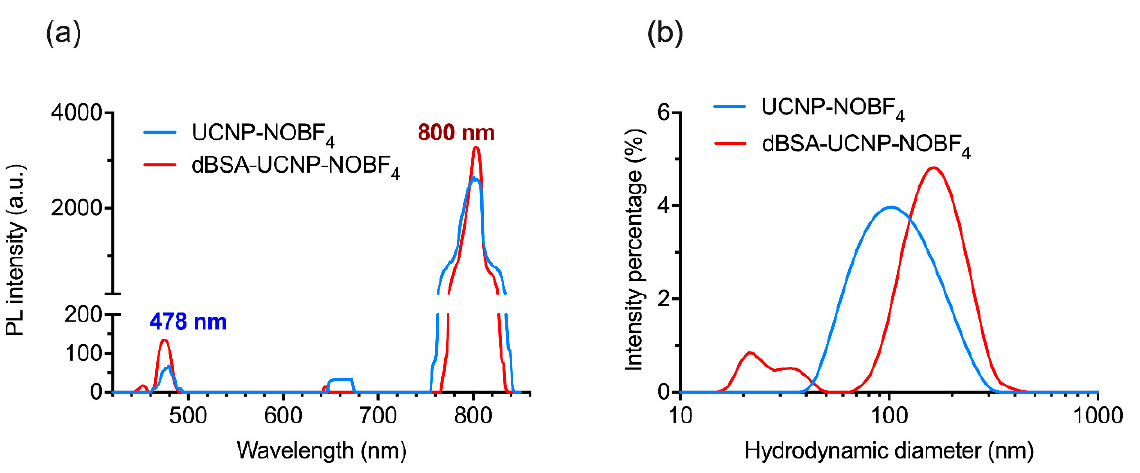
Figure 5. Characterization of UCNP-NOBF 4 and lyophilized dBSA-UCNP-NOBF 4 (dBSA at optimal concentration—10 µ M): ( a ) PL emission spectrum of UCNP-NOBF 4 and lyophilized dBSA-UCNP-NOBF 4 under excitation at 980 nm; ( b ) hydrodynamic diameter distributions of UCNP-NOBF 4 and lyophilized dBSA-UCNP-NOBF 4 acquired by DLS in deionized water.